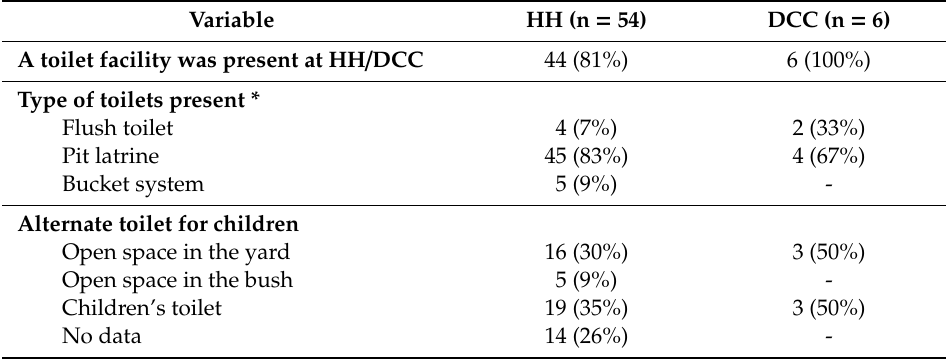
Table 2. Descriptive sanitation demographics for the study households (HH) and